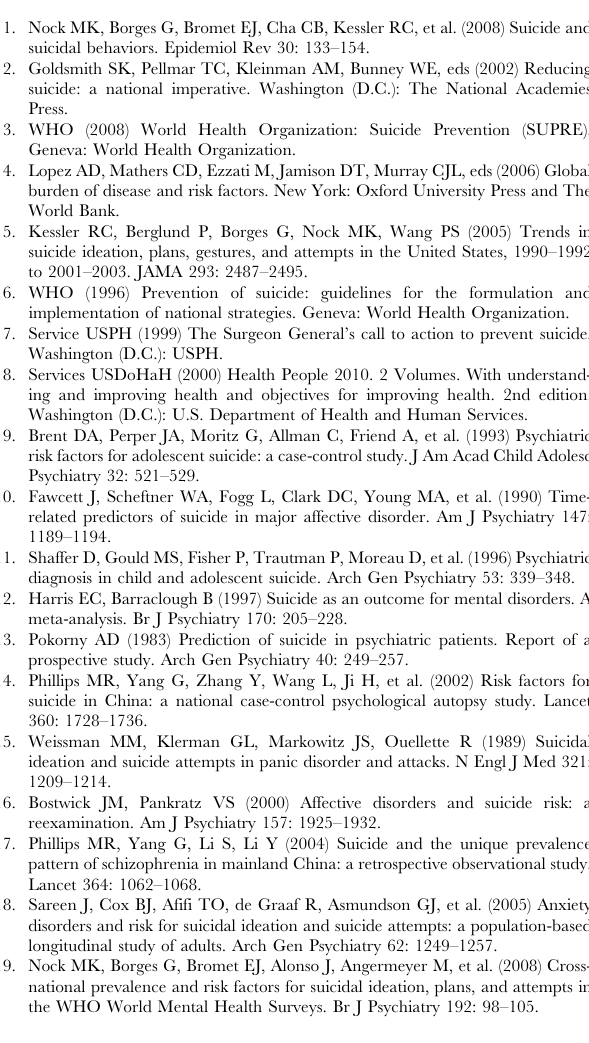
Table S3 Multivariate survival models of interactive associations between type and number of temporally primary lifetime DSM- IV/CIDI disorders in predicting the subsequent first occurrence of suicidal behaviors—developed countries.